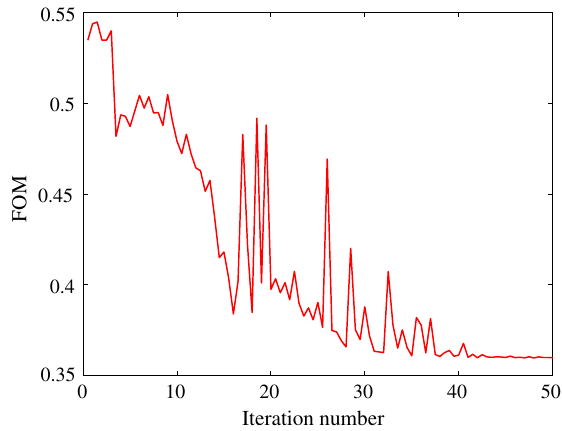
FIG. 2. FOM as a function of the iteration number computed by the optimizer during the optimization of the SwissFEL injector at 200 pC, 9.9 ps laser pulse length, described in Sec. III